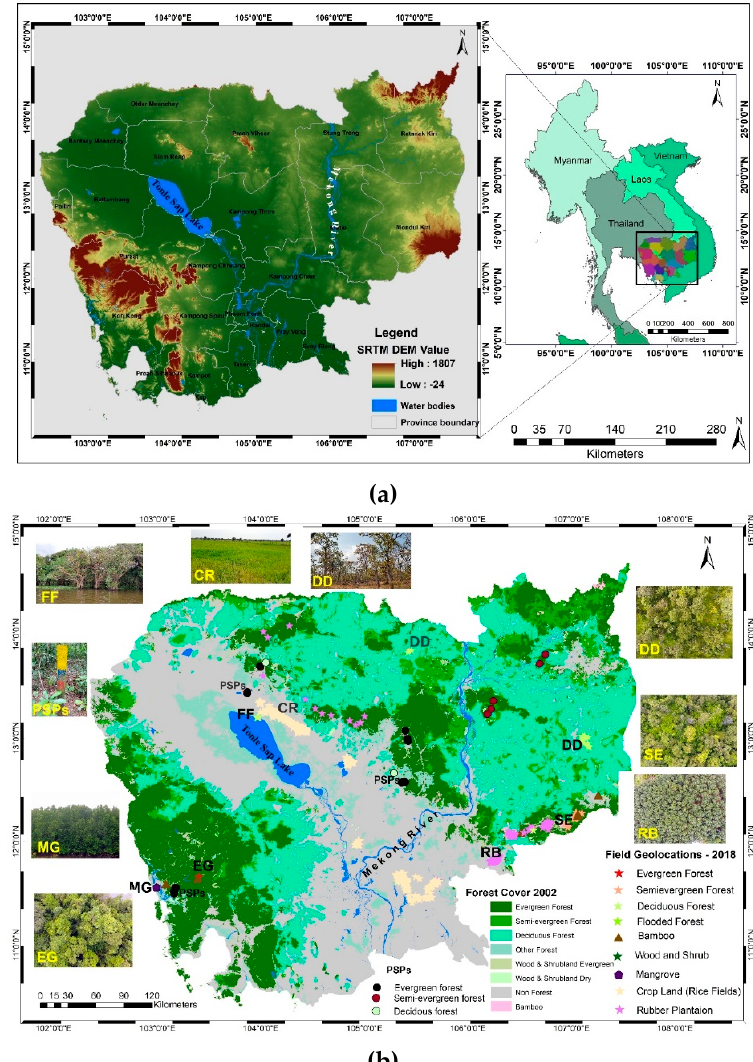
Figure 1. ( a ) Location map of the study area showing the elevation of Cambodia. This map was produced by the Shuttle Radar Topography Mission (SRTM) [66]. Red color indicates high elevation and mountainous regions, while yellow and green colors indicate medium highlands and land surfaces with low elevation, respectively. The Tonle Sap lake and Mekong river are shown as water bodies. ( b ) Forest cover map in 2002 and geolocations of the field reference data collected in 2018. The star symbols represent the geolocations of land cover categories during field observations in February and July 2018. The dot symbols show the locations of the Permanent Sample Plots (PSPs) in evergreen (EG), semievergreen (SEG), and deciduous forests (DD). The red dots represent semievergreen forest locations where an inventory was conducted (refer to Reference [67] for details.) The photos shown on the maps were taken during the field visits and represent flooded forests (FF), PSPs, mangroves (MG), EG, rice or paddy fields (CR), DD, SEG, and rubber plantations (RB). EG, SEG, DD, and RB aerial photos were taken from the drone Phantom 4 (of DJI company) in July 2018. Reference data for the land cover were obtained from Sasaki et al., 2016 [65].